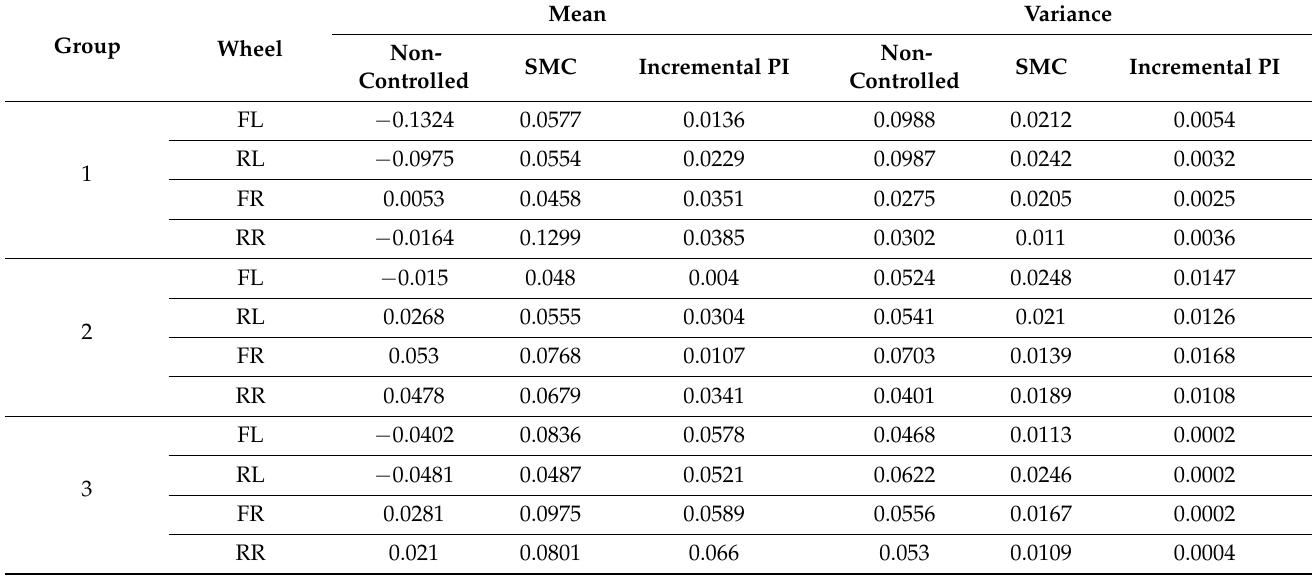
Table 2. Travel reduction feature of the test.